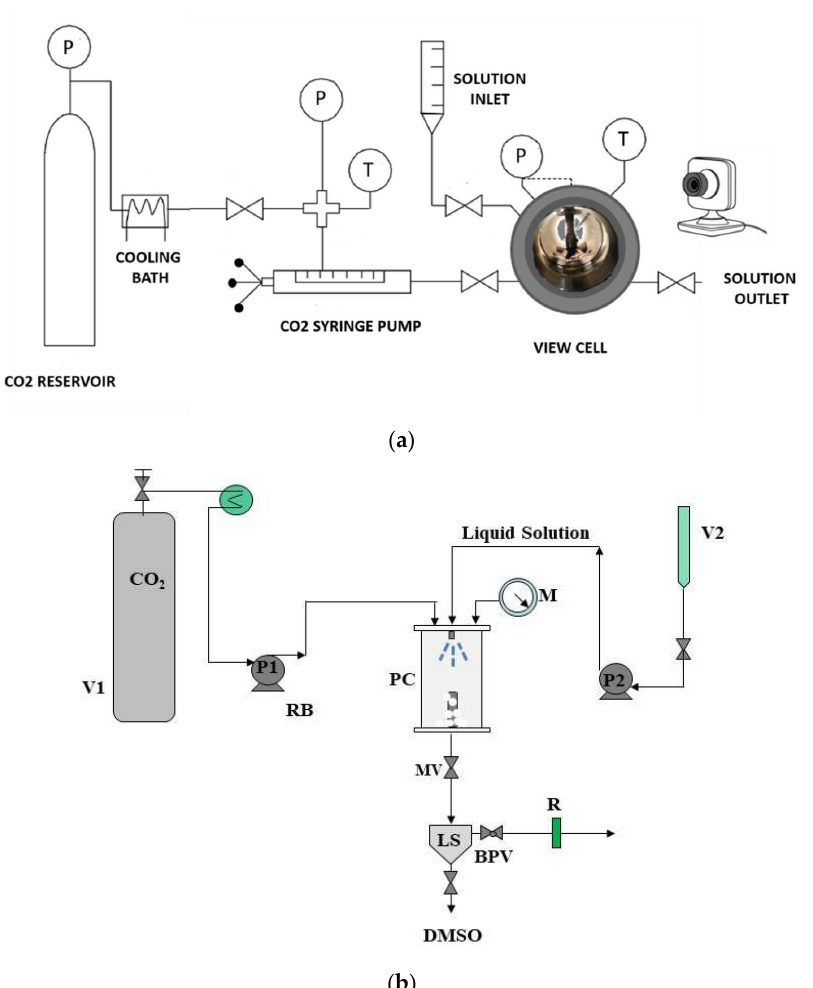
Figure 1. ( a ) View cell equipment; ( b ) SAS apparatus. BPV: back-pressure valve; LS: liquid separator; M: manometer; MV: micrometric valve; P1 and P2: pumps; PC: precipitation chamber; R: rotameter; and V1 and V2: storage vessels.